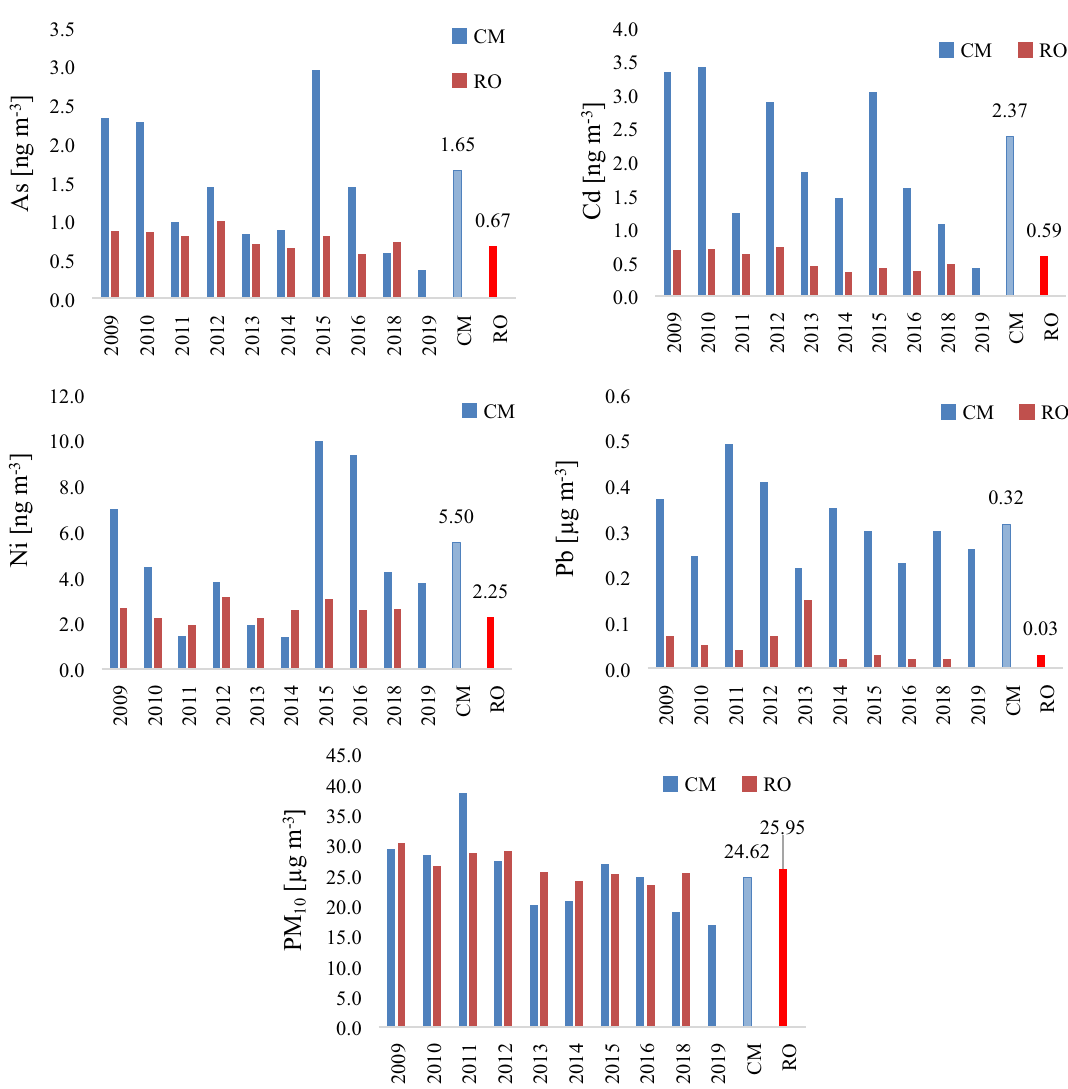
Figure 2. Annual variations in trace element concentrations and particulate matter. The figures were prepared using the Microsoft Excel